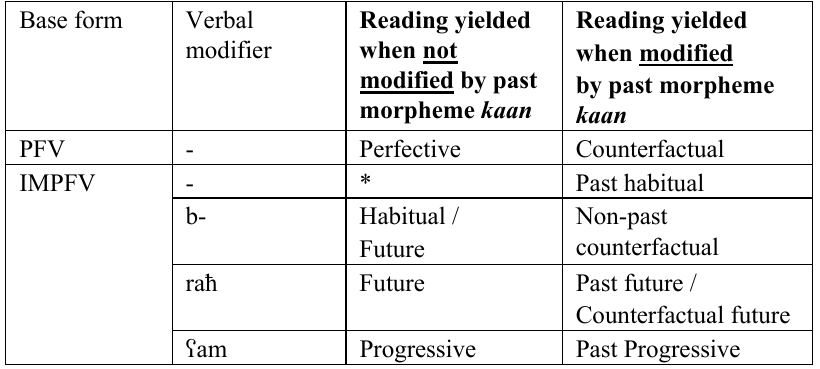
Table 1: Overview of the perfective and imperfectve forms and their